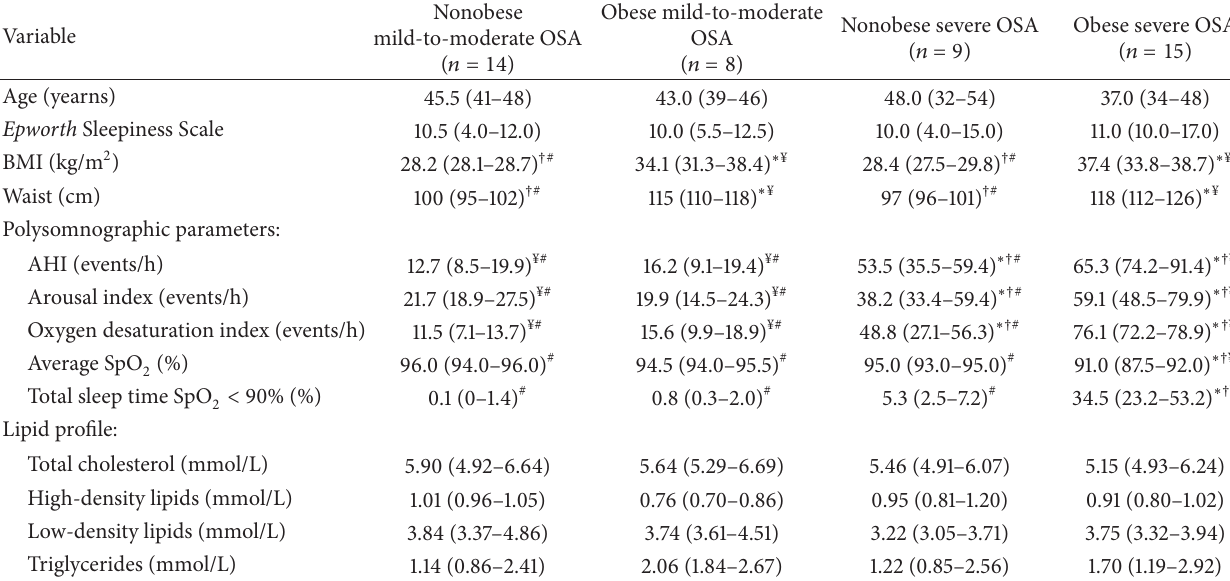
Table 2: Characteristics of obese and nonobese men with mild-to-moderate and severe obstructive sleep